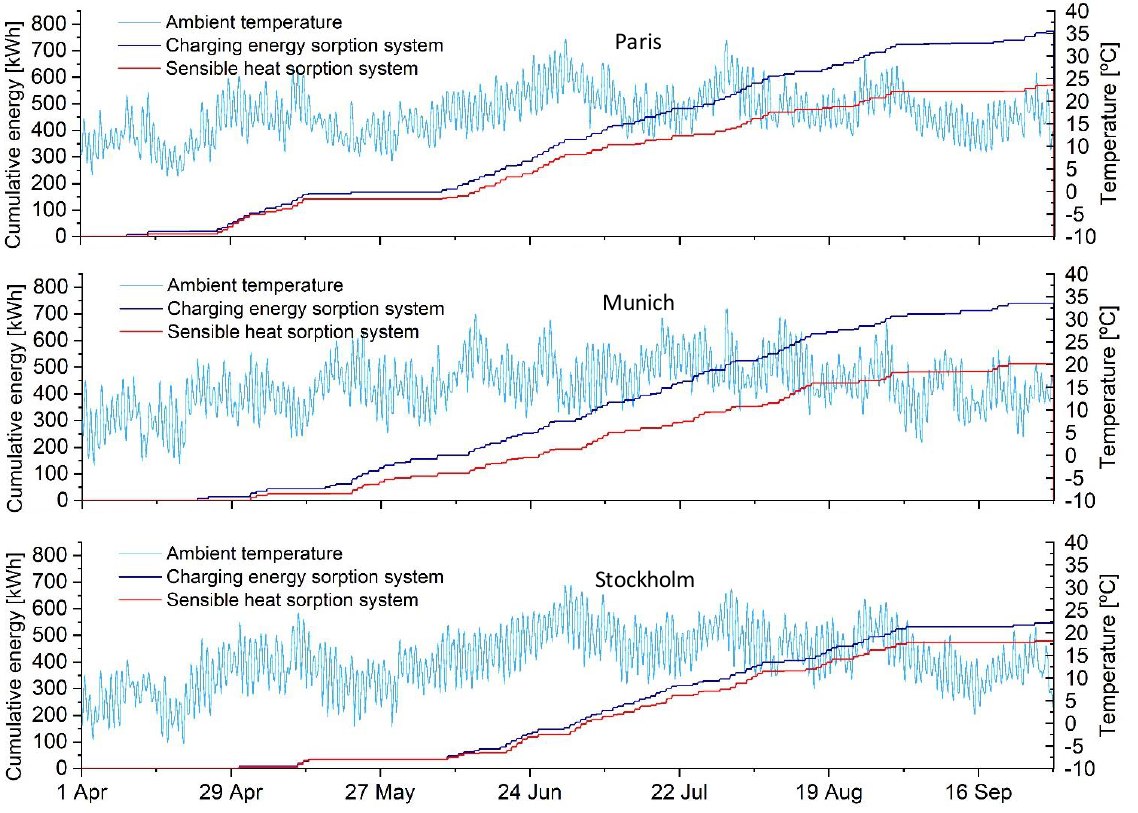
Figure 10. Variables of Paris, Munich, and Stockholm during summer (from April to September).